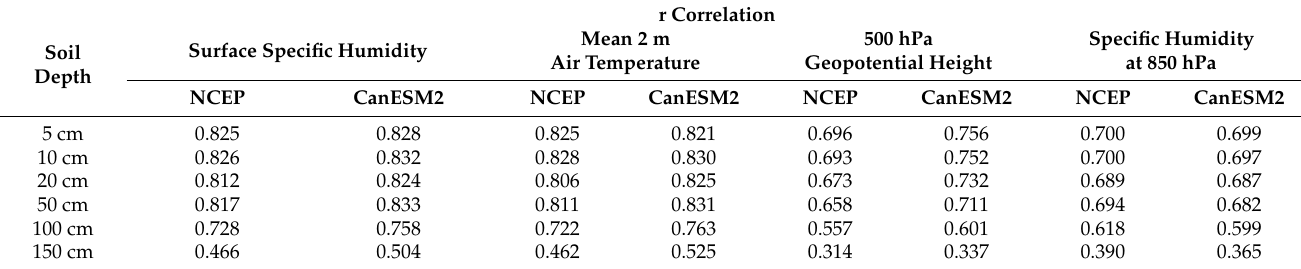
Table 3. r correlation between the four selected variables and observed soil temperature, with bolded numbers indicating the model variable having a stronger correlation on the soil temperature than the other model.